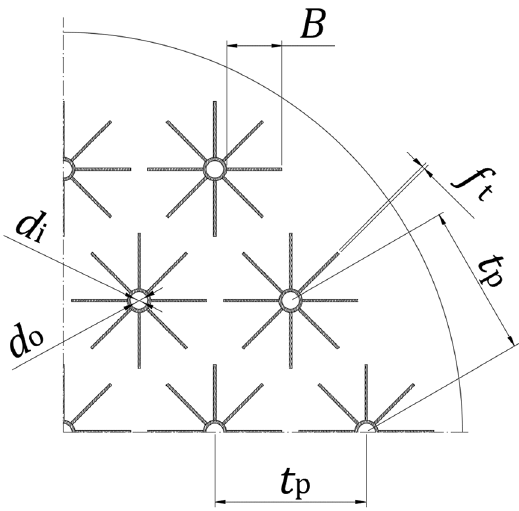
Figure 2. Top view of the section of analyzed LTES tank. Table 1. Geometry parameters of the analyzed LTES.